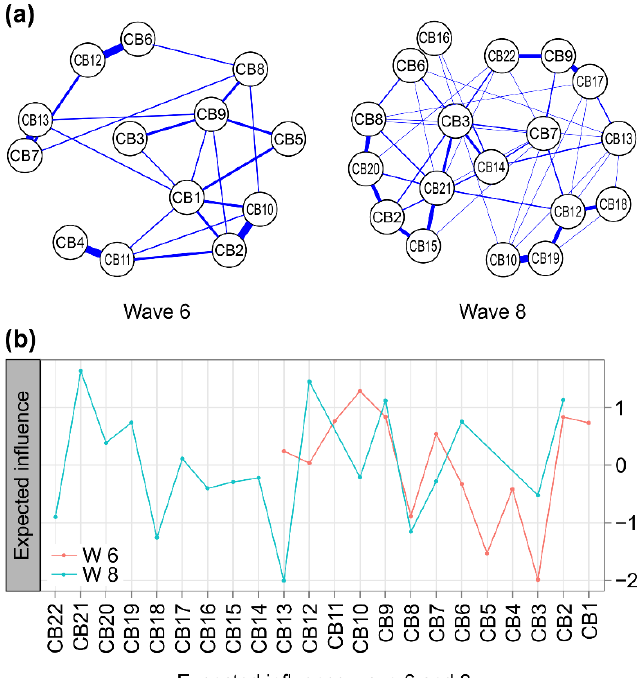
Figure 2. ( a ) Comparison of networks of 13 nodes with CBCL behavioral problems at 5 years (left) and 18 nodes at 7 years (right). The blue lines present positive associations, and the red lines indicate negative ones. The width and brightness of the edge indicate the strength of the association. The maximum edge of w6 is 0.64 (CB7 = aggressive behaviors; CB13 = DSM oppositional defiant problems), and the maximum edge of w8 is 0.73 (CB6 = attention problems; CB16 = social problems). ( b ) Individual node strength values are shown as standardized z -scores for w6 (orange) versus w8 (blue). CB1 = emotionally reactive; CB2 = anxious/depressed; CB3 = somatic complaints; CB4 = withdrawn; CB5 = sleep problems; CB6 = attention problems; CB7 = aggressive behaviors; CB8 = other problems; CB9 = DSM affective problems; CB10 = DSM anxiety problems; CB11 = DSM pervasive developmental problems; CB12 = DSM attention-deficit/hyper-activity problems; CB13 = DSM oppositional defiant problems; CB14 = withdrawn/depressed; CB15 = rule-breaking behavior; CB16 = social problems; CB17 = thought problems; CB18 = DSM somatic problems; CB19 = DSM conduct problems; CB20 = obsessive–compulsive symptom; CB21 = posttraumatic stress problems; CB22 = sluggish cognitive tempo.